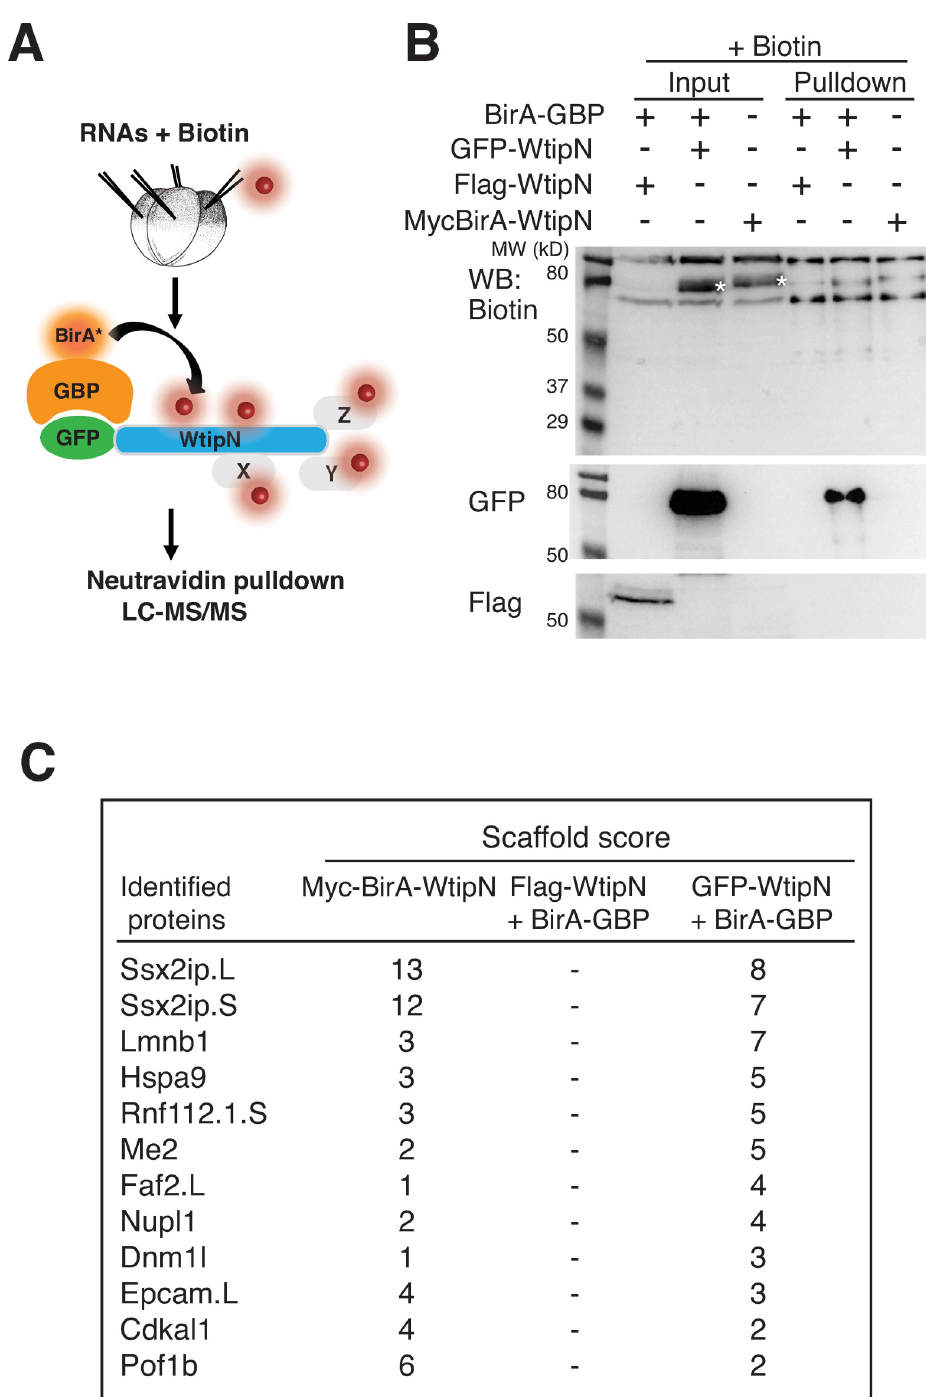
Fig 3. Identification of SSX2IP by targeted proximity biotinylation. A, Scheme of targeted proximity biotinylation (TPB) with GFP-WtipN. Early embryos were injected with indicated RNAs (200 pg each) and biotin (1.2 mM). B, Biotinylated proteins were enriched with neutravidin agarose beads and immunoblotted with indicated antibodies. Biotinylated GFP-WtipN (asterisk) but not Flag-WtipN in the presence of BirA-GBP was detected in the pulldown. MycBirA-WtipN (asterisk) was biotinylated in the absence of BirA-GBP. C, Top hits identified by SCAFFOLD after LC-MS/MS analysis in both experimental groups but not in the negative control group.